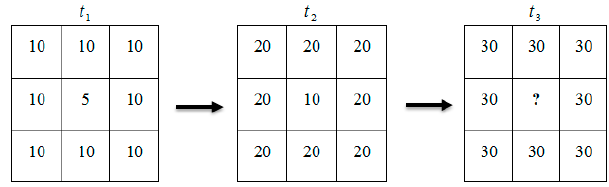
Figure 7. Background intensity prediction for frames with spatial heterogeneity.